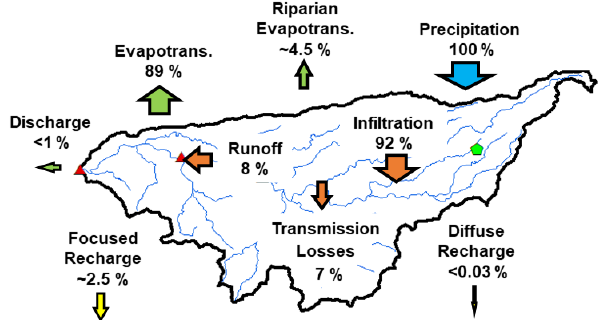
Figure 11. Average fluxes of different components of the water bud- get of WGEW for the simulated period, between 1 January 2007 and 1 January 2018. Water stored in the soil and the riparian zone corresponds to ∼ 3%. Blue arrows show input fluxes, green arrows represent water leaving the catchment, orange arrows represent in- ternal surface and unsaturated zone fluxes, and yellow arrows rep- resent water moving to the saturated zone (groundwater flow not